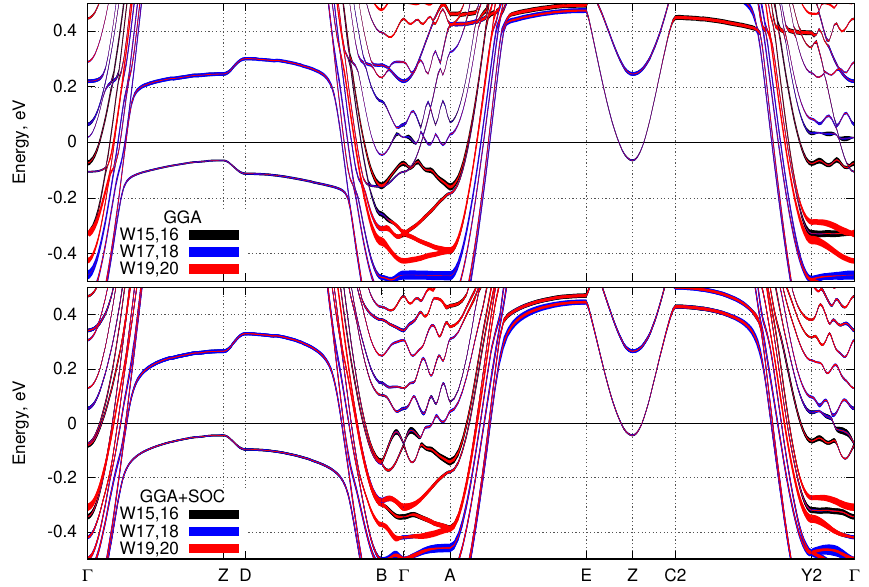
Figure 4. DFT-calculated band structure without SOC ( top ) and with SOC ( bottom ). The orbital character of the tungsten atoms W15–W20 are shown by different colors and the width of each curve is proportional to the contribution of the corresponding orbital. Zero corresponds to the Fermi